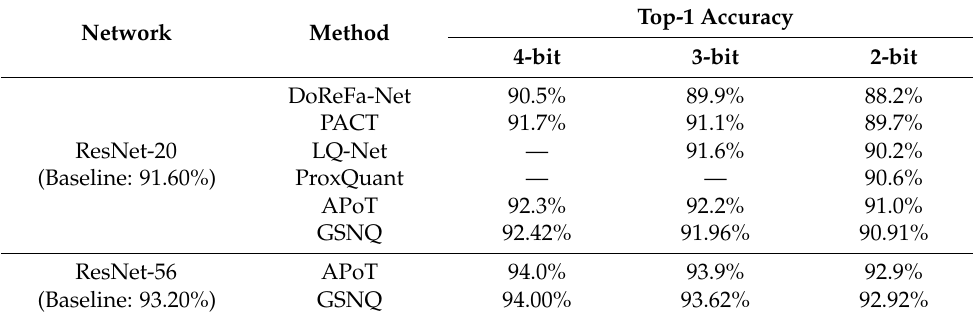
Table 10. Comparison between ResNet-20 and ResNet-56 on